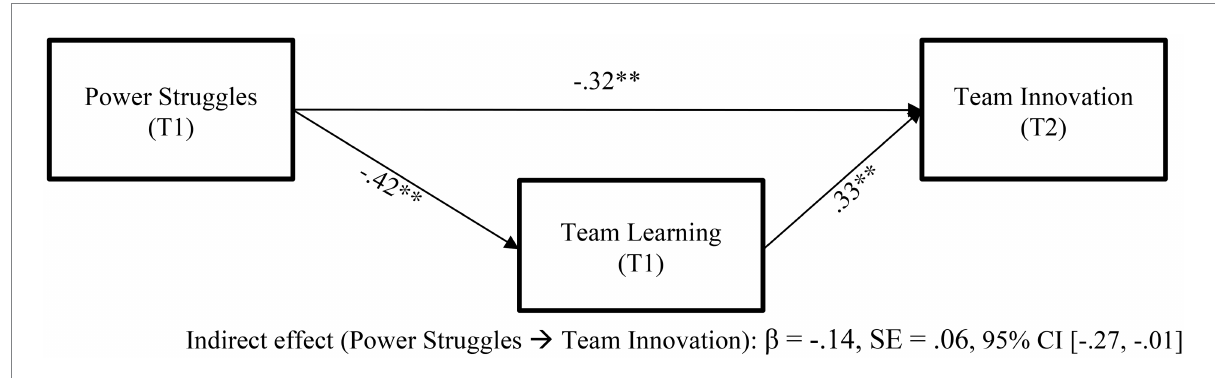
FIGURE 1 Summary of hypotheses. * p < 0.05. ** p <